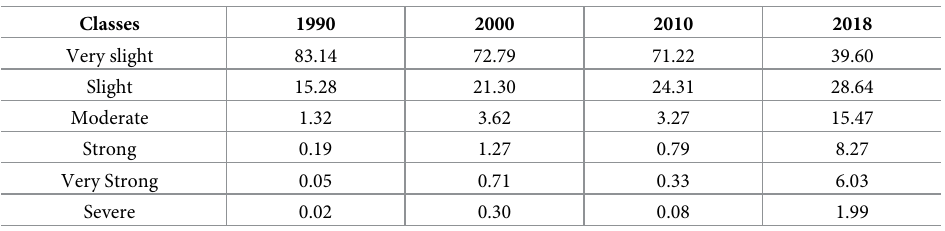
Table 3. Soil erosion severity class areal distribution from 1990 to